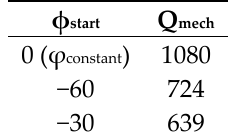
Figure 5. Normalized amplitude characteristics of the cantilever tip when applying a phase shifted excitation. The inserted detail serves as guide to the eyes. Table 1. Table of Q-factors obtained by LDV measurements when applying a phase-shifted stimulus to the MEMS